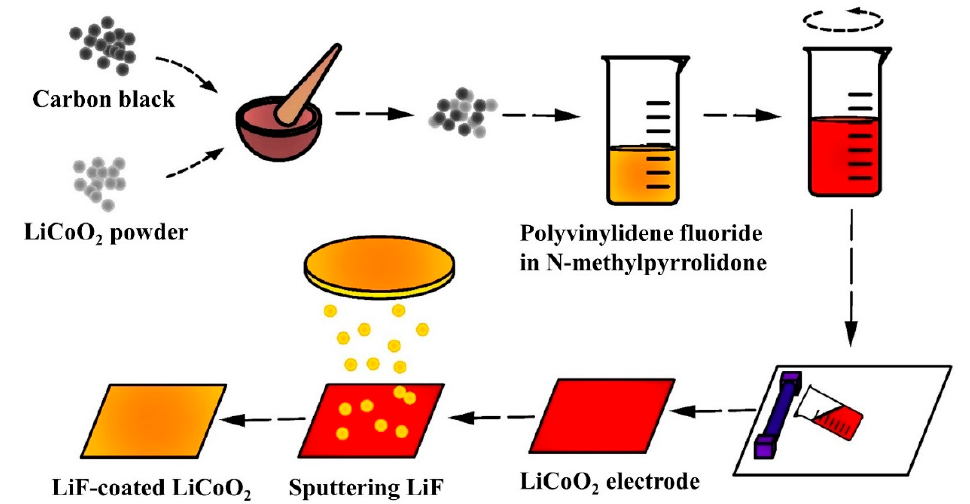
Figure 1. Fabrication process of LiF-coated LCO electrodes by casting and sputtering.